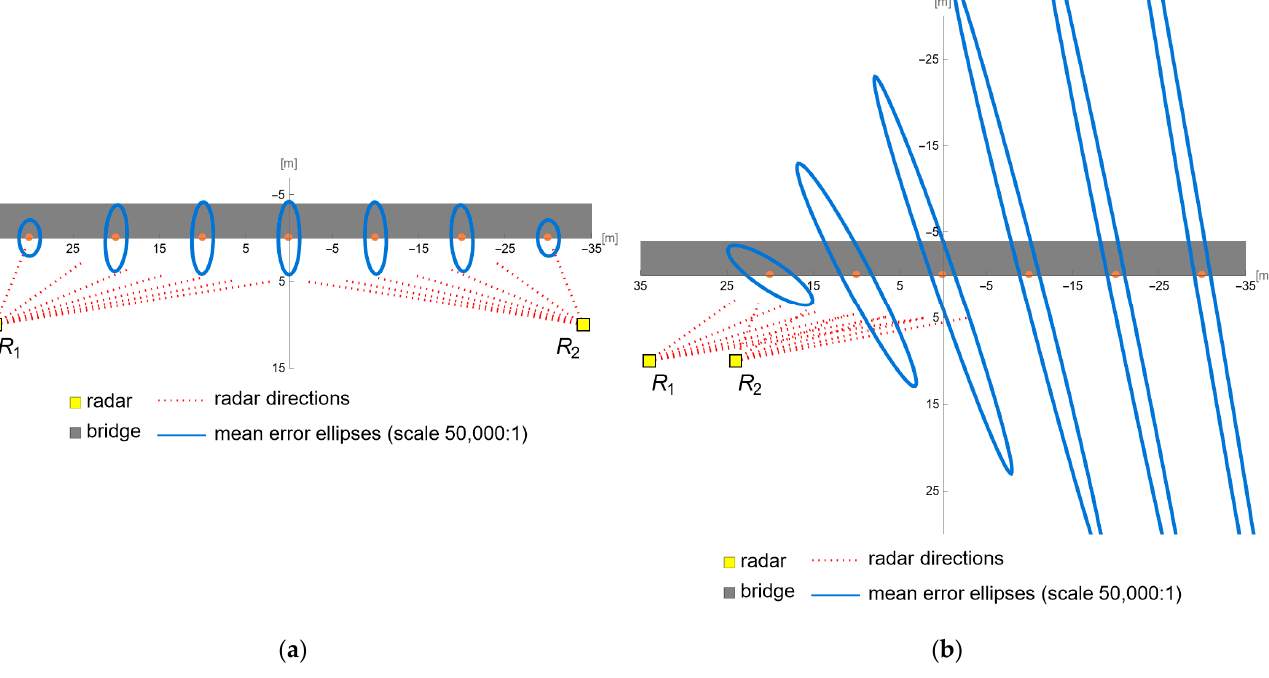
Figure 7. Accuracy of displacement vector [ s X , s Y ] = [ 0.0 mm, 5.0 mm ] at various points on the bridge. Positions of the radars are determined with precision 0.2 m. Standard deviation of measured LOS displacements is 0.02 mm. Scale of the mean error ellipses is 50,000:1. ( a ) radars are placed at opposite ends of the bridge; ( b ) radars are placed behind each other.